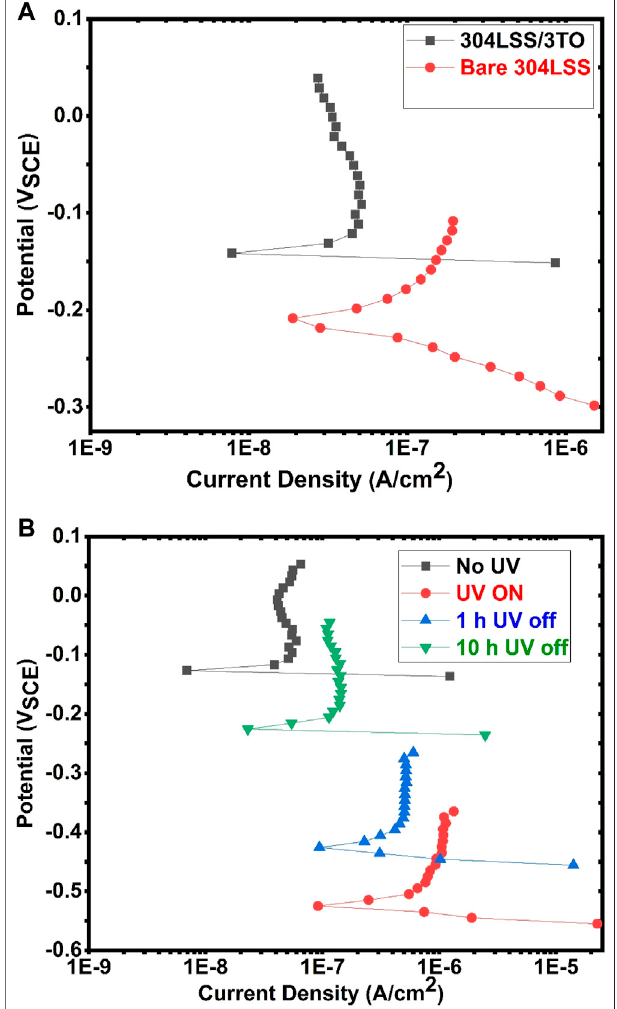
FIGURE 11 | (A) Polarization curves of the uncoated 304LSS sample andthe304LSS/3TOsample. (B) Polarizationcurvesoftheuncoated304LSS sample in the absence of UV illumination and of the 304LSS/3TO samples at different